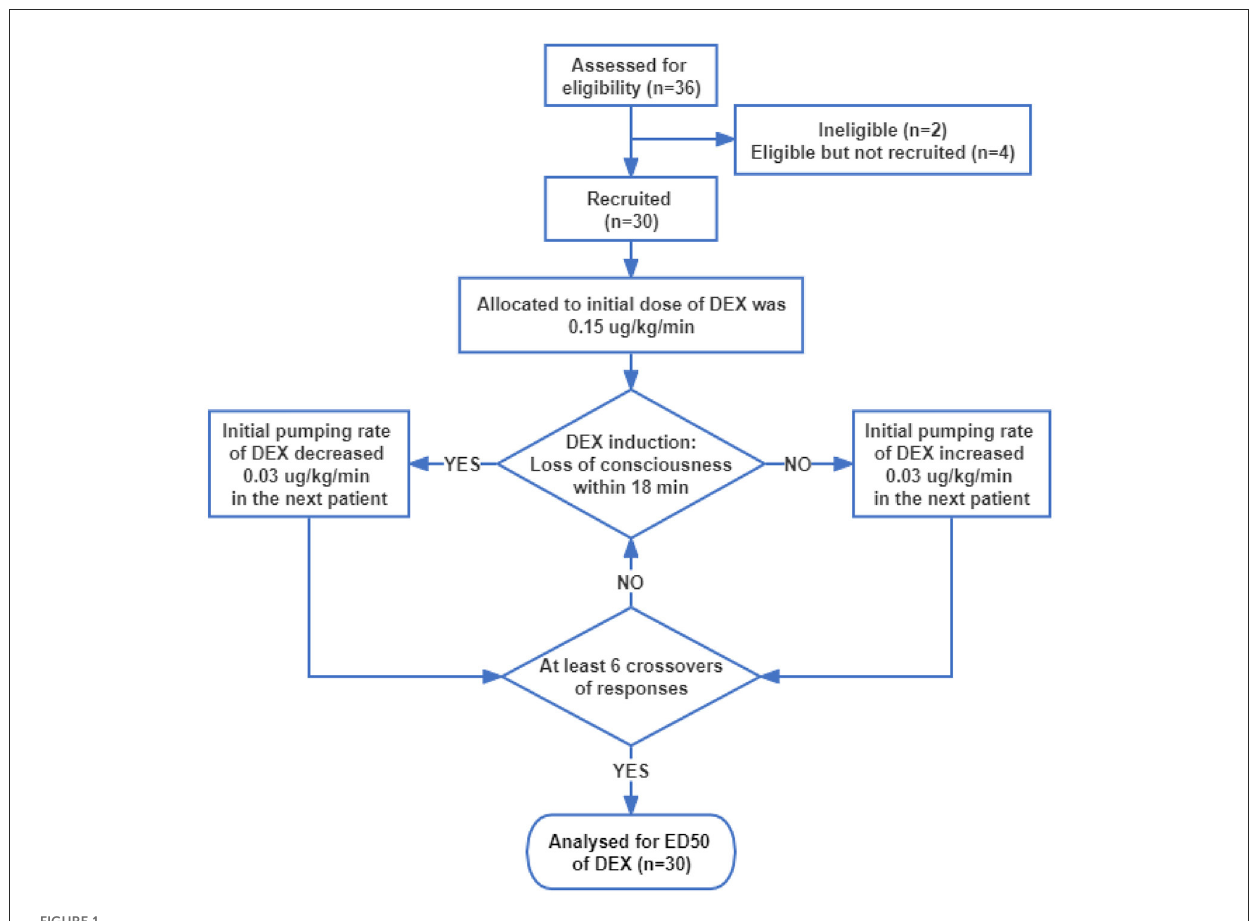
FIGURE1 Flow chart for this Dixon’s up-and-down sequential